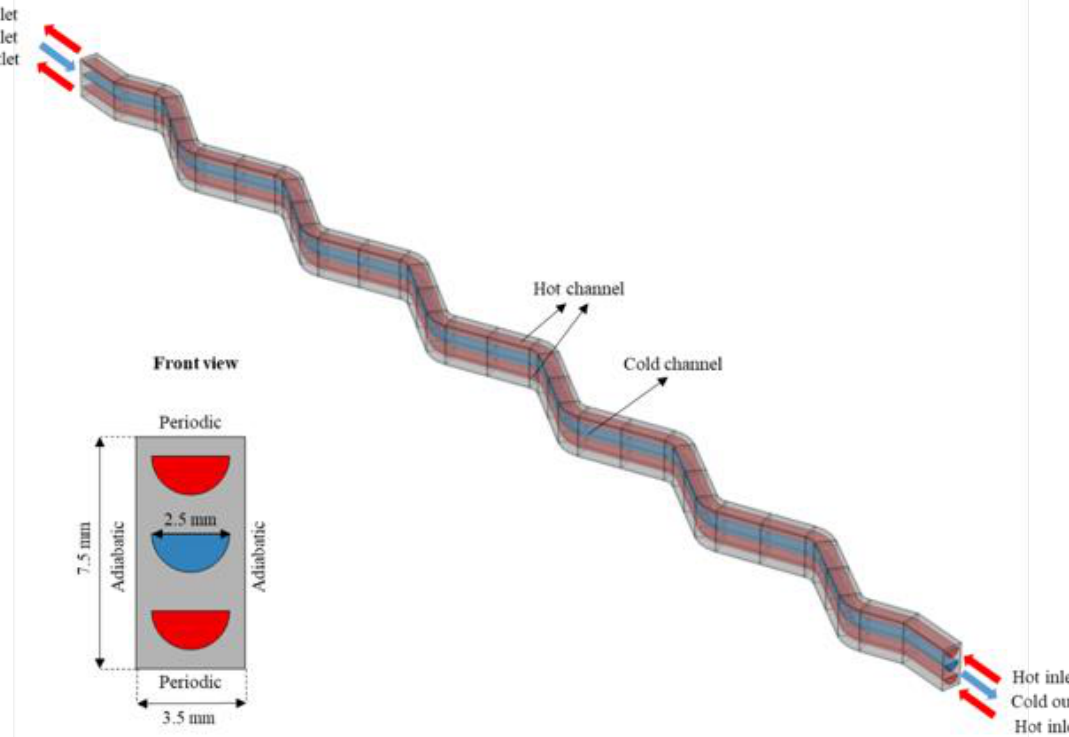
Figure 4. The simplified model of PHE with zigzag flow channels. The boundary conditions are adiabatic on the lateral surfaces and periodic on the top and bottom surfaces.